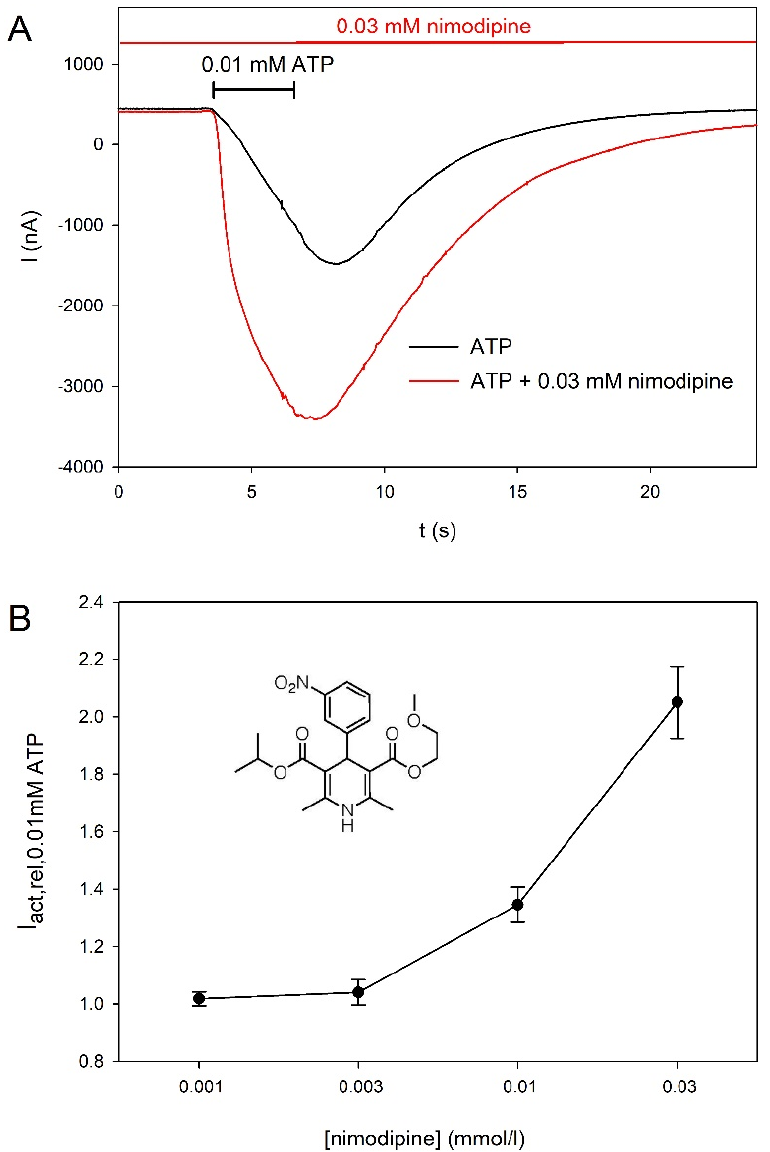
Figure 6. Concentration-dependent effect of nimodipine on hP2X5 FL -mediated currents. ( A ) Example current traces consecutively evoked by ATP and ATP + nimodipine. ( B ) Concentration dependence of the effect of nimodipine on ATP-elicited hP2X5 FL -mediated currents. Means are from of 6–40 oocytes. The structure of nimodipine is shown in the inset.